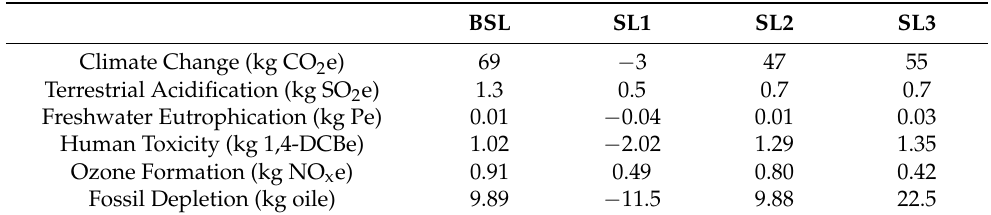
Table 5. Environmental impact potentials per tonne of cane processed for different cane leaves utilization scenarios.